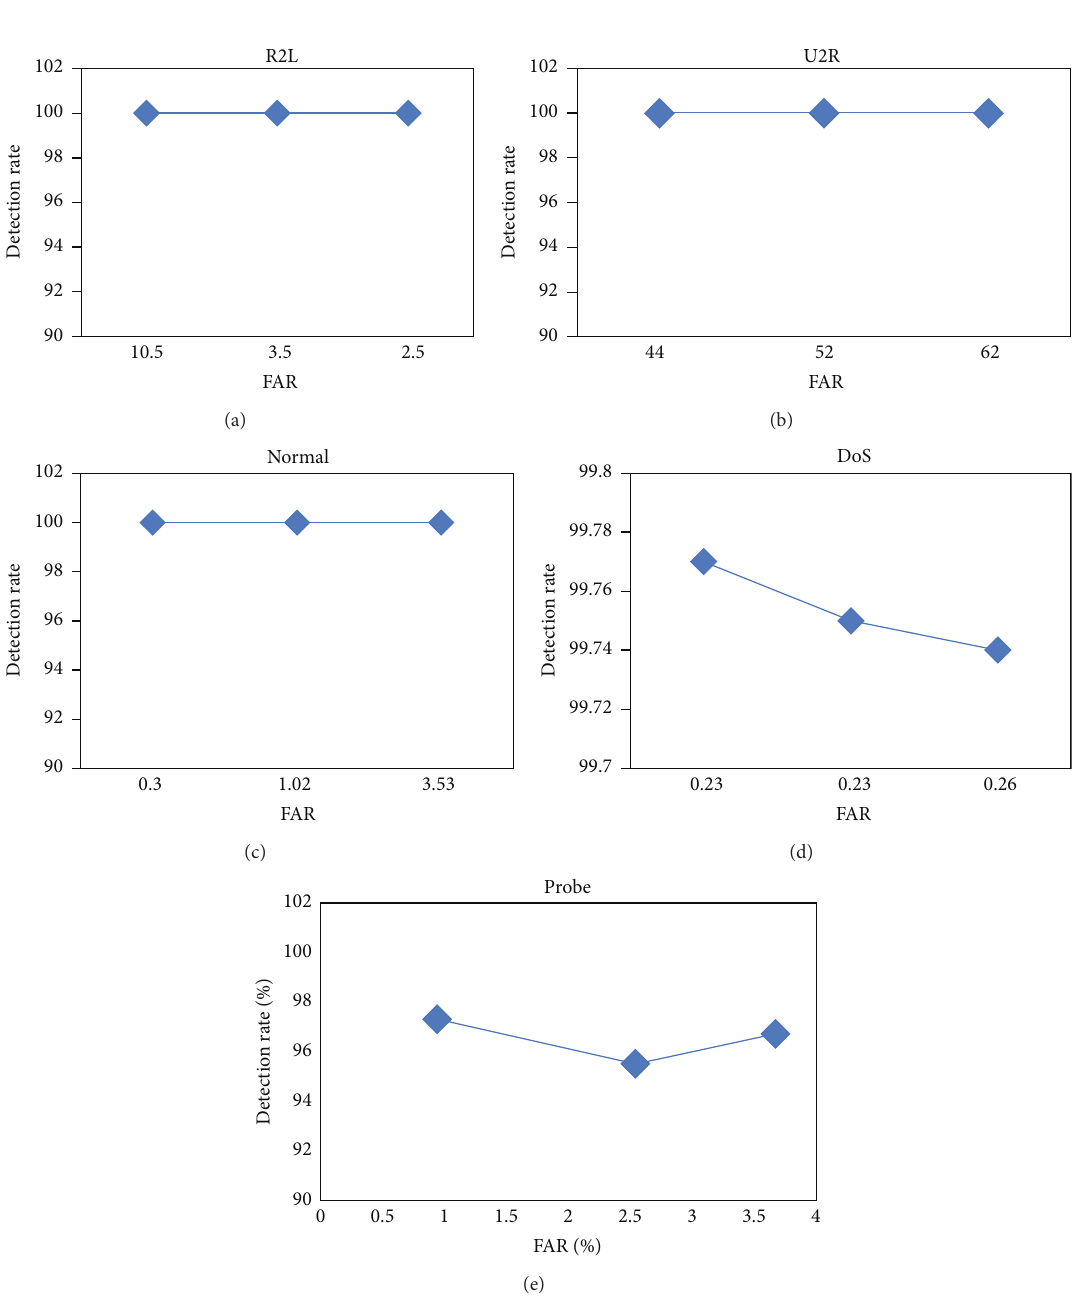
Figure 1: ROC curve for all